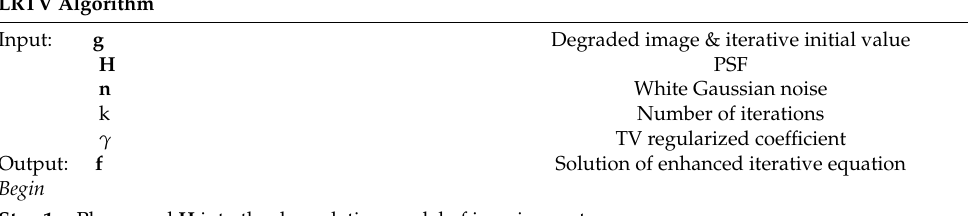
Table 1. The detail implementation steps of the LRTV algorithm. LRTV